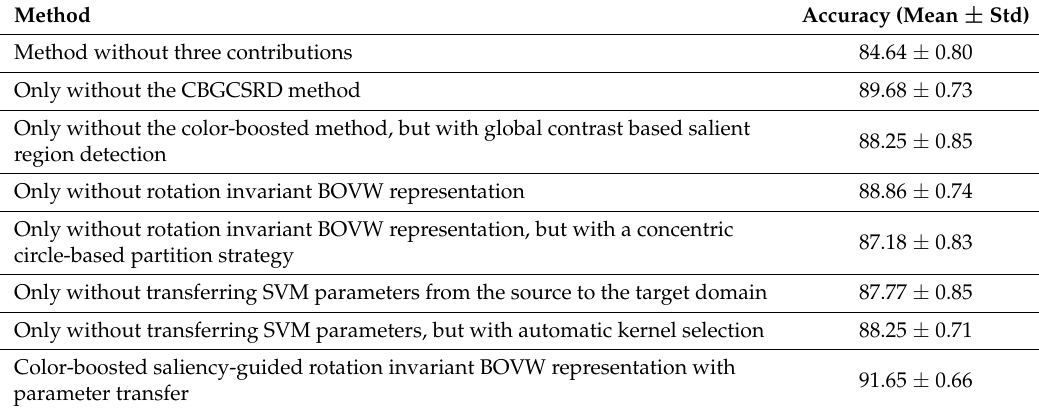
Table 6. Comparison with methods concerning three contributions in the SIRI-WHU dataset.